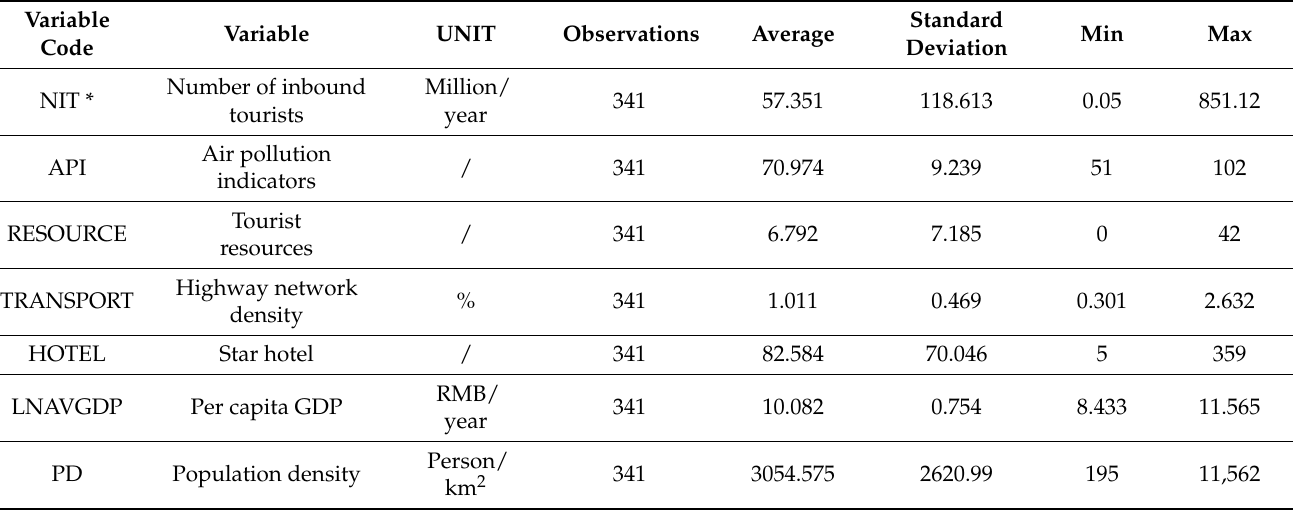
Table 1. Variable descriptive